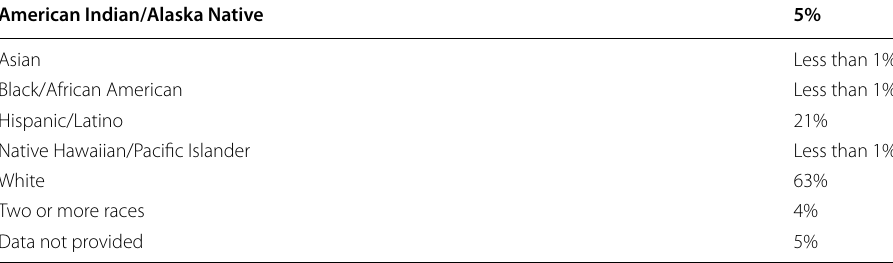
Table 1 Race and ethnicity of